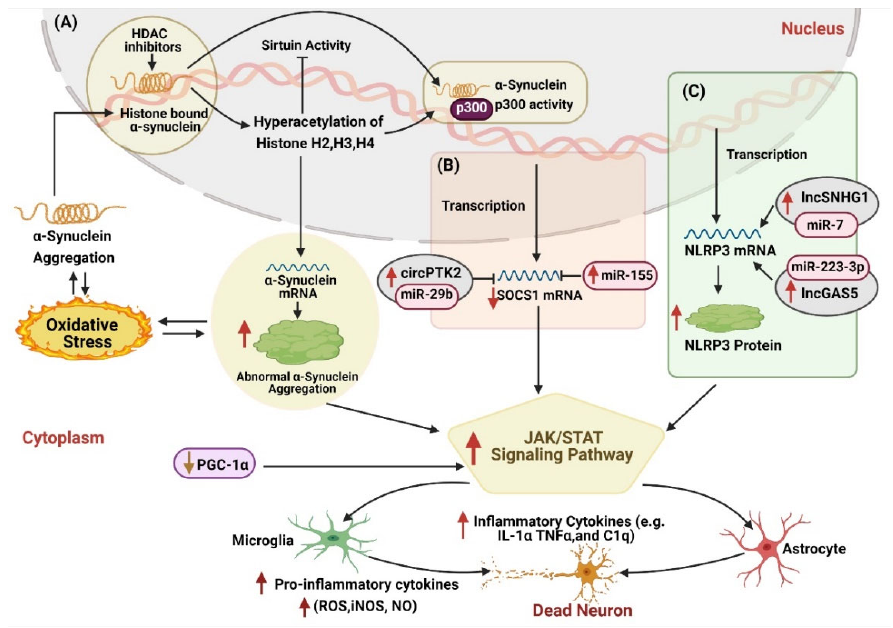
Figure 5. The landscape of synergic epigenetic interactions with JAK/STAT signaling pathway in PD development. JAK/STAT signaling pathway activation involves multiple epigenetic events. ( A ) Hyperacetylation of Histone H2, H3, and H4 results in the overexpression of the SNCA gene, which leads to α -synuclein aggregation and JAK/STAT signaling pathway activation. ( B ) Higher expression of miR-155 and circPTK2 sponging with miR-29b inhibit SOCS1 expression that accelerates neuronal apoptosis through SOCS-1-JAK2/STAT3-IL-1 β signaling. ( C ) Similarly, synergic interaction of lncSNHG1 sponging with miR-7 and lncGAS5 sponging with miR-223-3p activates NLRP3 inflammasome, which transforms glial cells to the inflammatory phenotype and the aggregation of α -synuclein. Moreover, lower expression of PGC-1 α also contributes to JAK/STAT signaling pathway activation. Altogether, these epigenetic mechanisms interact with each other and with JAK/STAT signaling pathways to induce neuroinflammation in PD development. Note: ↓ shows downregulated expression, and ↑ shows an upregulated